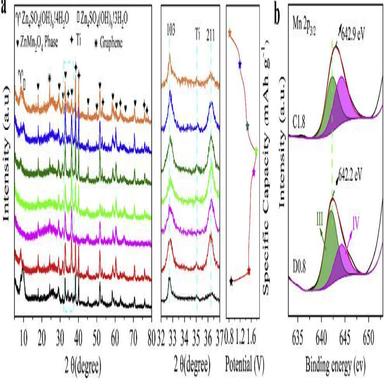
(a) The ex-situ XRD patterns of ZnMn2O4/NG at different charge/discharge states for the third cycle, and (b) ex-situ XPS study of ZnMn2O4/NG at charge and discharge states.